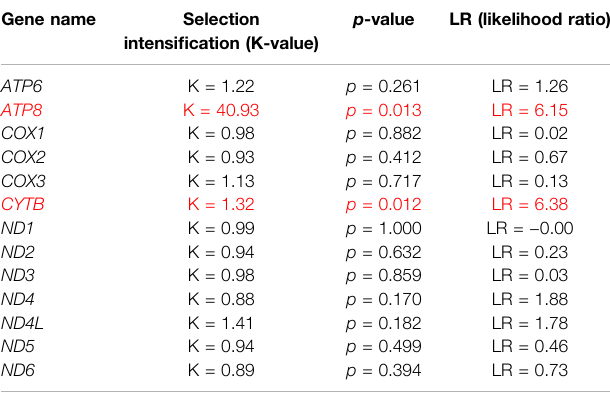
TABLE 3 | Intensi fi ed and relaxed selection for mitochondrial protein-coding genes on the anadromous branches. Gene name Selection intensi fi cation